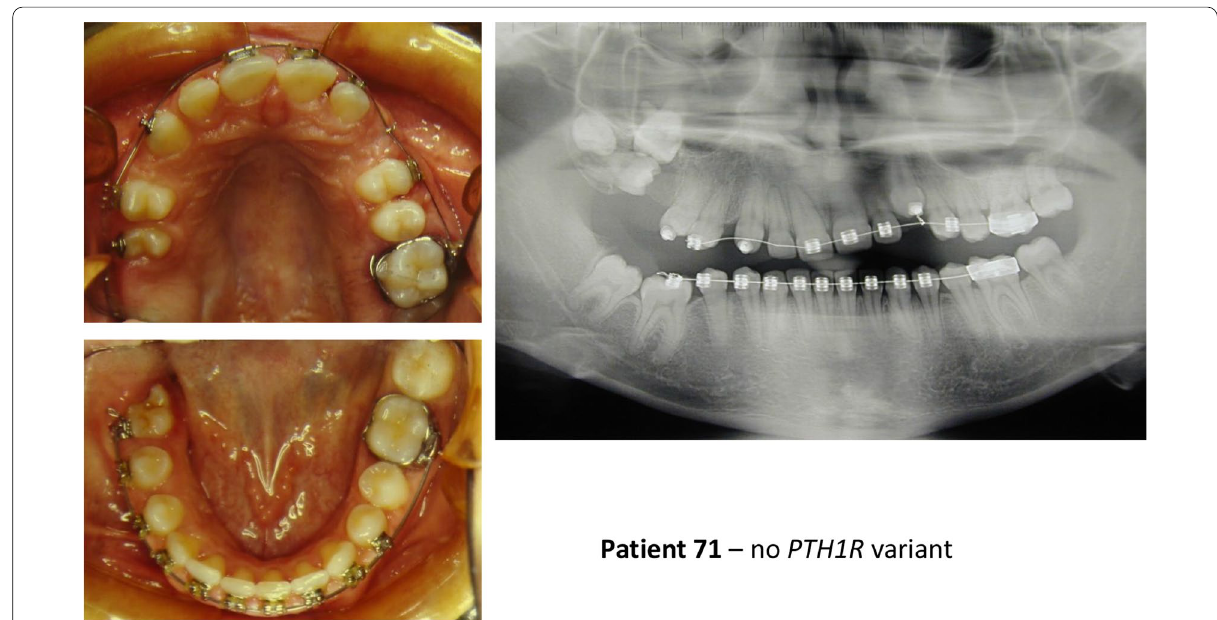
Fig. 5 Clinical features and genetic findings of patient 71 with PFE but without PTH1R variants